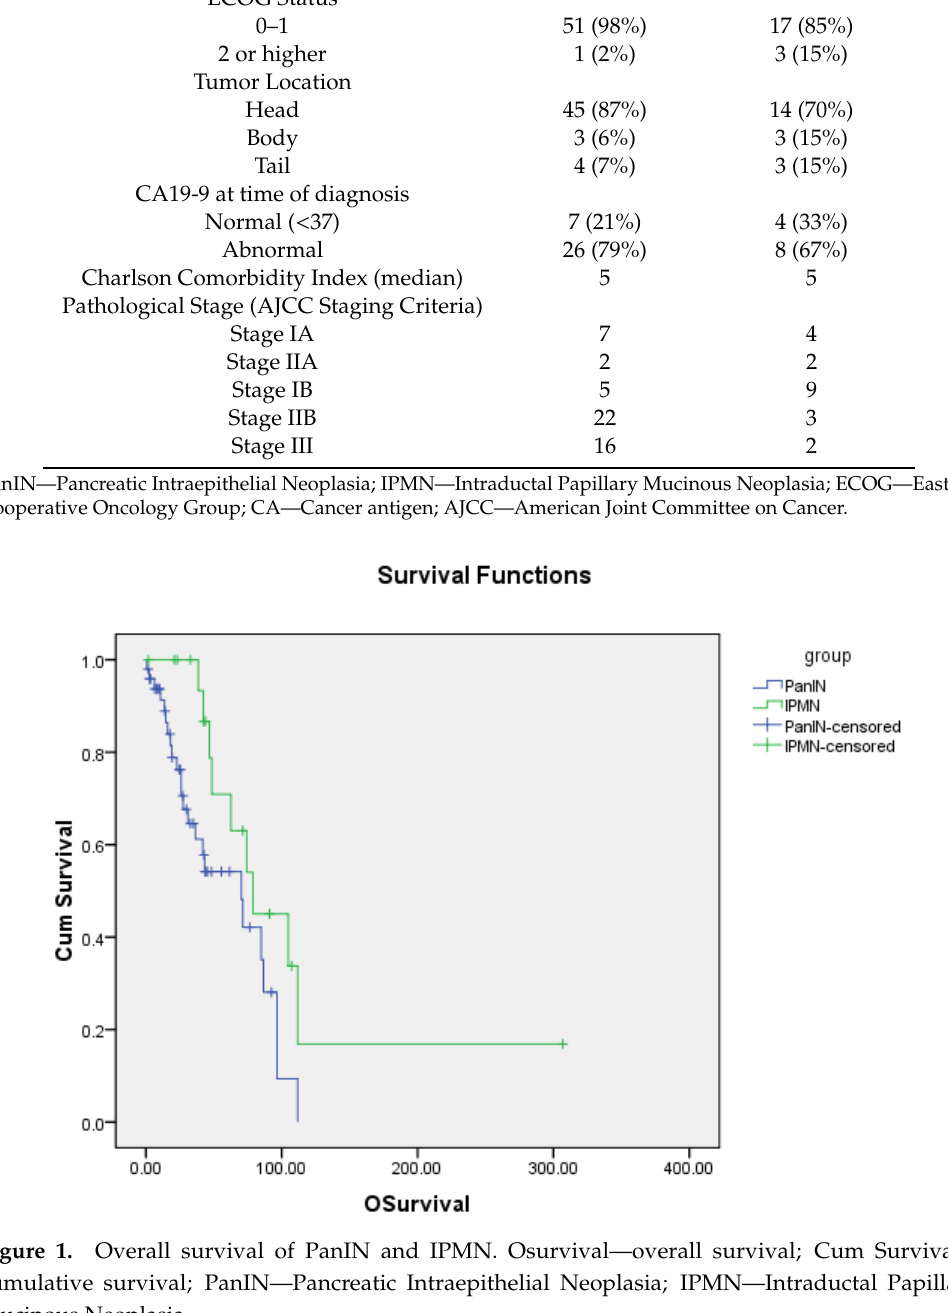
Figure 2. Progression free survival of PanIN and IPMN. RFSurvival — Progression Free Survival Overall, 33 patients (46%) were found to have recurrence of pancreatic cancer in this study. Of those, 11 had local recurrence and 22 had distant recurrence. Local recurrence in the PanIN group occurred in nine patients and distant recurrence occurred in 17 patients. Local recurrence in the IPMN group occurred in two patients and distant recurrence occurred in five patients. The location of tumor recurrence (local versus distant) for both IPMNs and PanINs combined did not show a statistically significant difference in OS ( p -value 0.33).